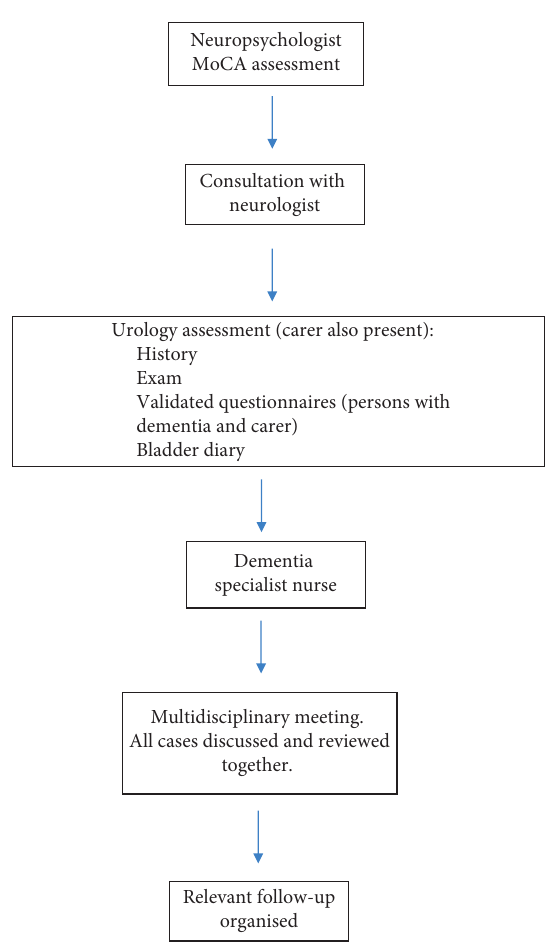
Figure 1: Flow diagram of the clinic